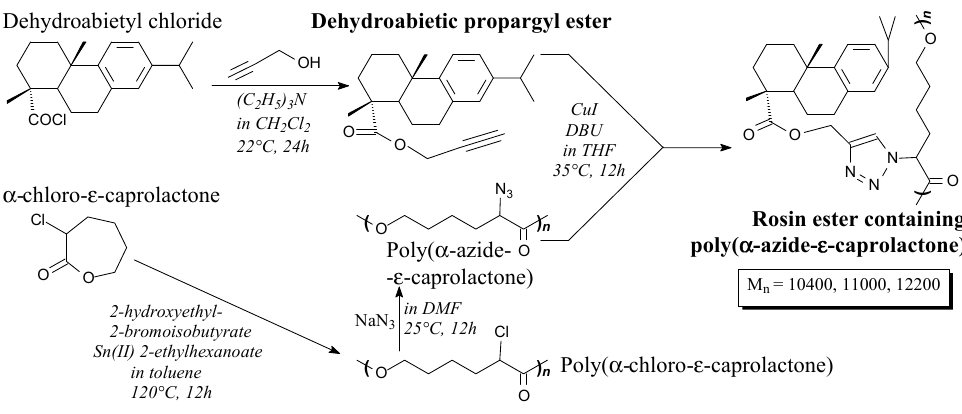
Scheme 81. Preparation of styrene and acrylic rosin ester copolymer.